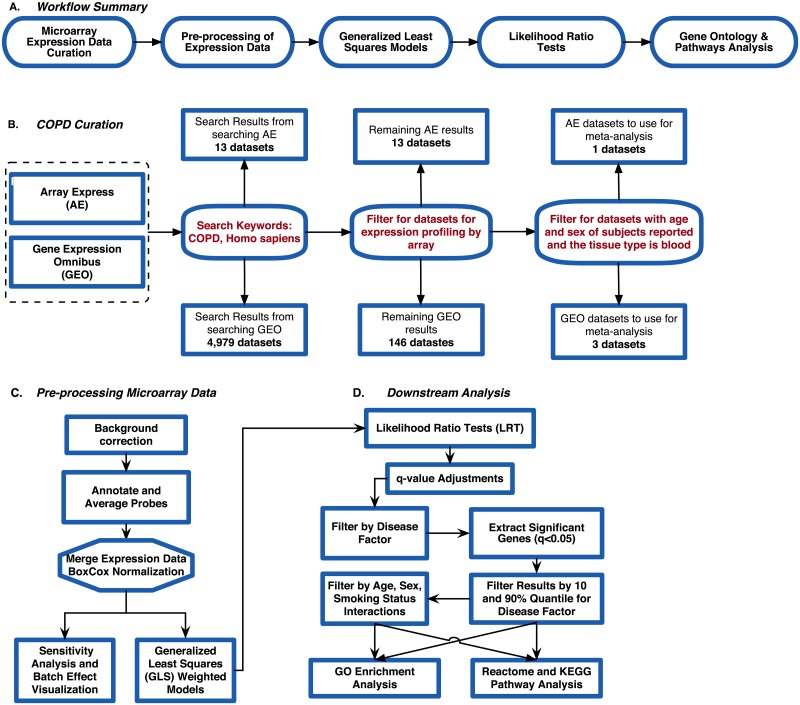
Analysis pipeline for chronic obstructive pulmonary disease.(A)Summary of workflow used for the re-analysis of microarrays, (B) Pre-processing steps used on the microarray data, (C) Data analysis post generalized least squares (GLS) model fit, (D)downstream analysis steps using GLS.